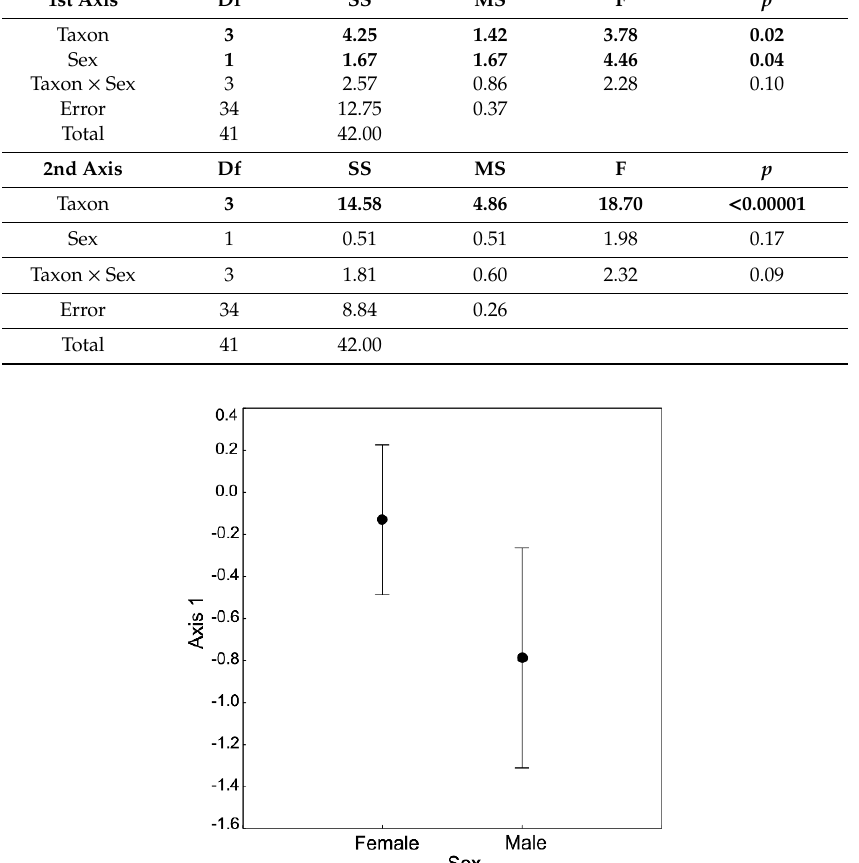
Figure 2. Multivariate analysis of stoichiometric relations in two sexes of spiders (PCA). ANOVA performed for the 1st axis scores (F = 4.46, p = 0.04). Bars denote the confidence intervals. Table 1 provides information on the contribution of different elements to the scores of Axis 1.